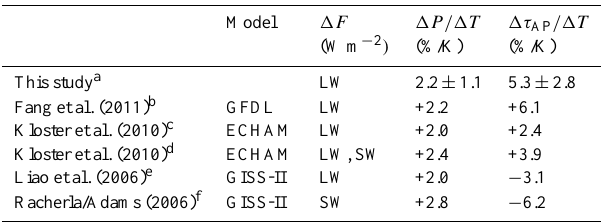
Table 1. Simulated temperature sensitivities of precipitation and sulfate